Question: What form of chart is displayed?
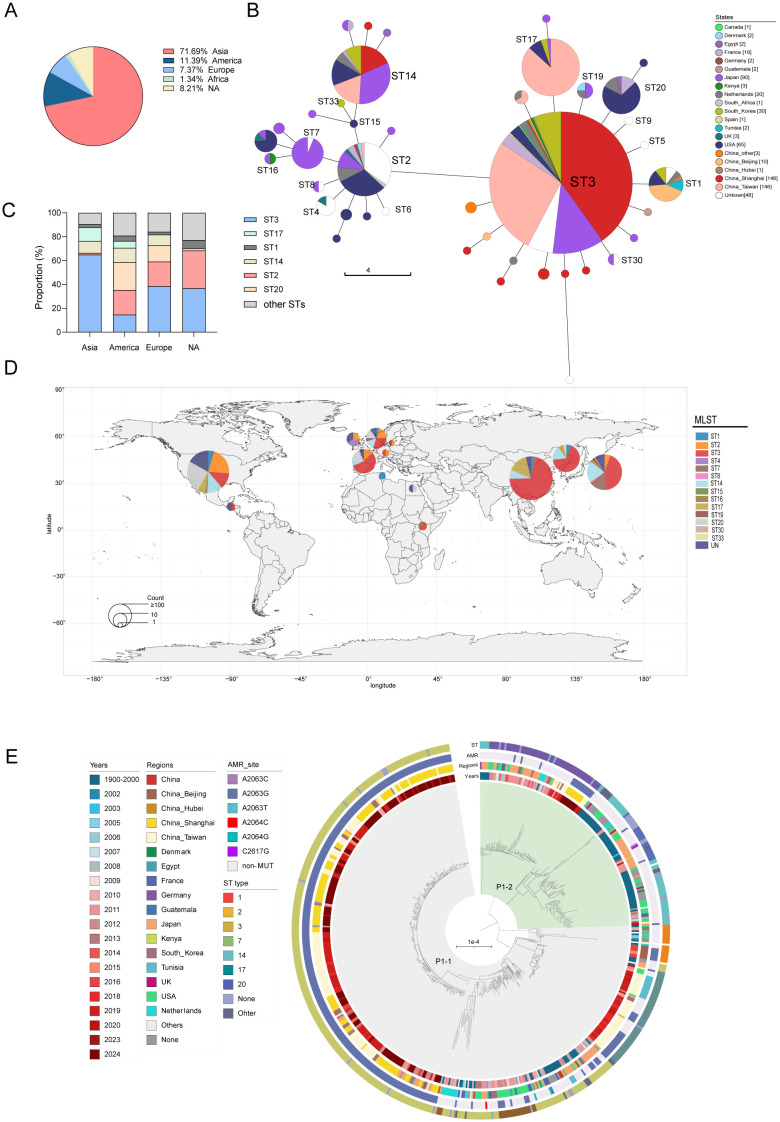
Answer: pie